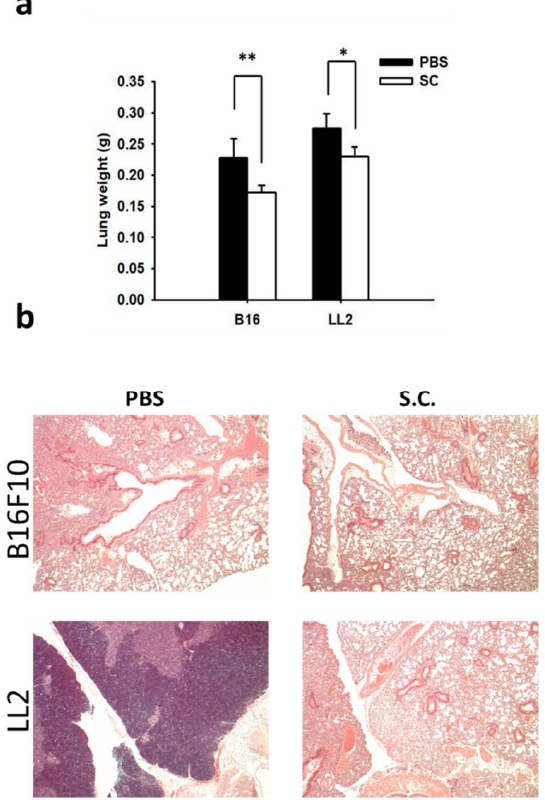
Figure 5. Salmonella (S.C.) inhibited metastasis in vivo. The C57BL/6 mice were injected with B16F10 and LL2 cells (10 5 ) pre-incubated with or without Salmonella (MOI = 10) for 4 h via the tail vein at day 0. ( a ) At day 20, the wet lung weight of the lungs was measured. ( n = 3, data are mean ± SD. * p < 0.05; ** p < 0.01). ( b ) The metastatic pulmonary nodules were observed after the intravenous injection of cells (×400).